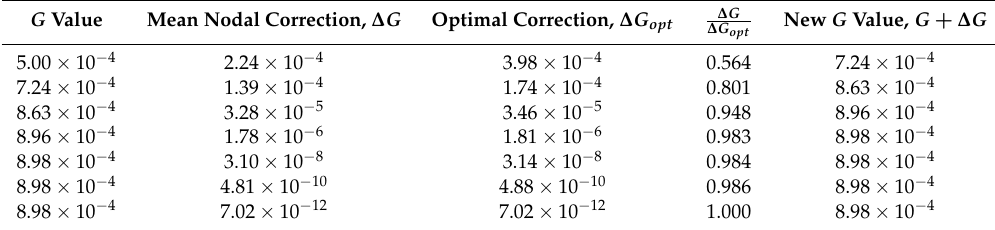
Table 3. Sequential optimization of G for the linear sloping domain compared to the 2D CG simulation with G = 0.001s − 1 . The units for each of the columns, except for the fourth column, are s − 1 . The ratios in the fourth column are